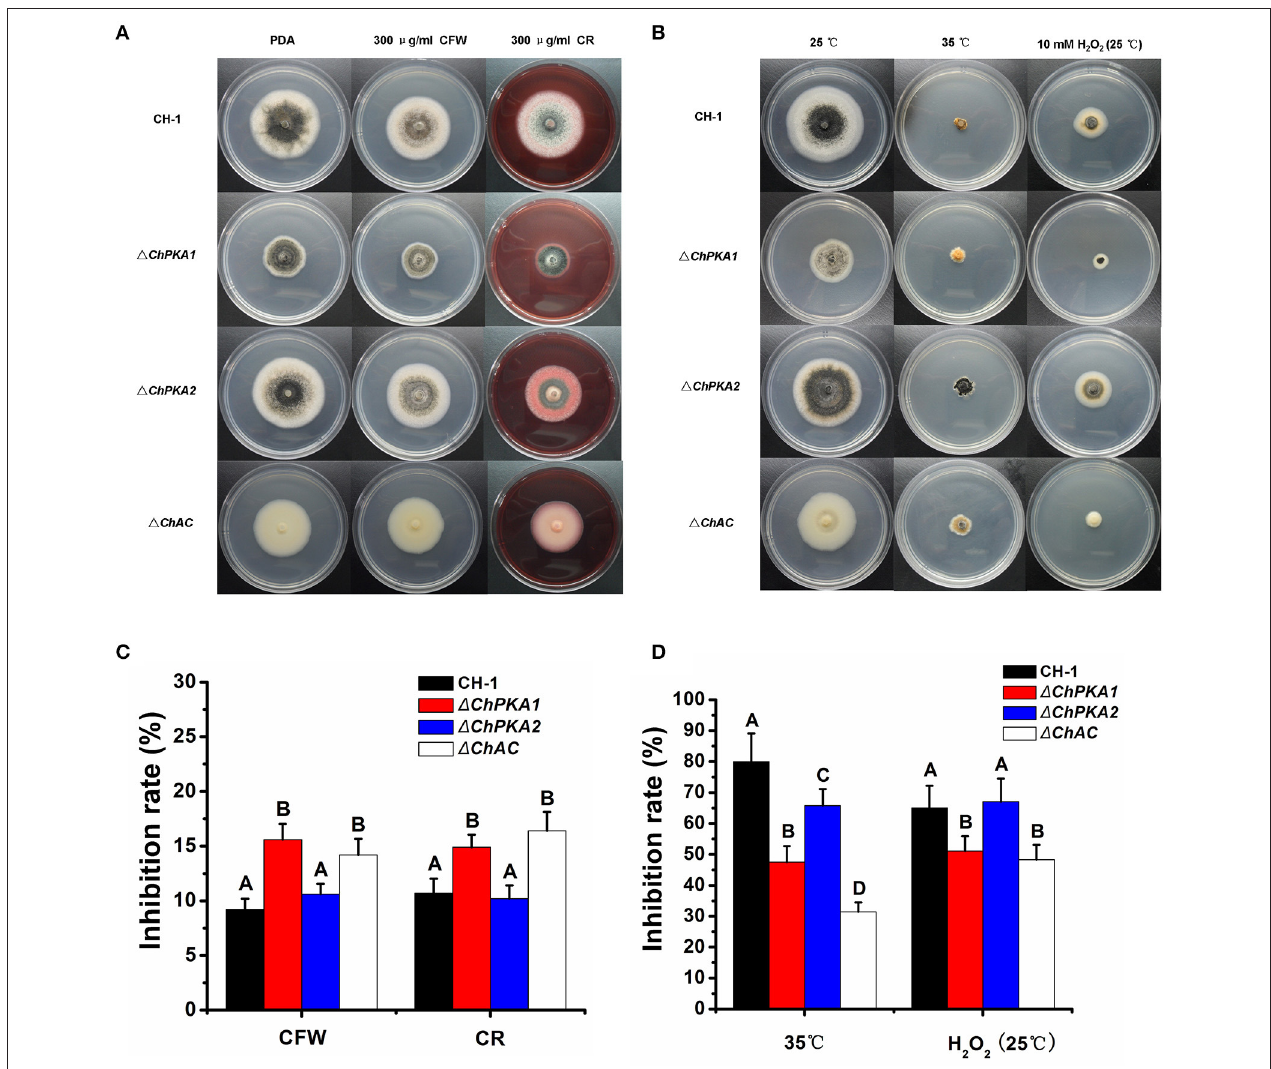
FIGURE 7 | Stress tolerance assays of wild type strain CH-1, ∆ ChPKA1 , ∆ ChPKA2, and ∆ ChAC . (A) CH-1, ∆ ChPKA1 , ∆ ChPKA2, and ∆ ChAC were treated with chemical components in PDA. Images were taken after 6 days of incubation on PDA with 300 µ g/ml CFW and 300 µ g/ml CR. (B) CH-1, ∆ ChPKA1 , ∆ ChPKA2, and ∆ ChAC cultured on PDA at different temperature or with 10mM H 2 O 2 . Images were taken after 6 days of incubation at 25 and 35 ◦ C, or with 10mM H 2 O 2 , respectively. (C) Inhibition rate of the radiated growth of CH-1, ∆ ChPKA1 , ∆ ChPKA2, and ∆ ChAC on the PDA with chemical components. (D) Inhibition rate of the radiated growth of CH-1, ∆ ChPKA1 , ∆ ChPKA2, and ∆ ChAC on the PDA at 35 ◦ C compared with that of their growth at 25 ◦ C or with 10 mM H 2 O 2 . Means and standard deviations were calculated from three replicates. Different letters in the graph indicate statistical differences, P ≤